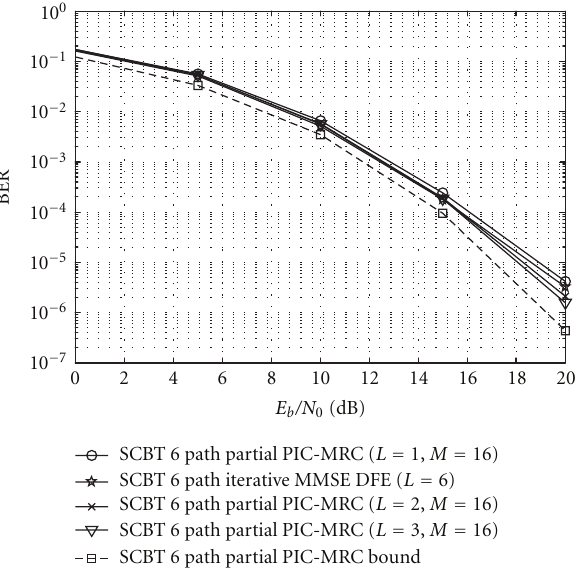
Figure 13: BER performance of iterative partial PIC-MRC and MMSE-DFE in SCBT